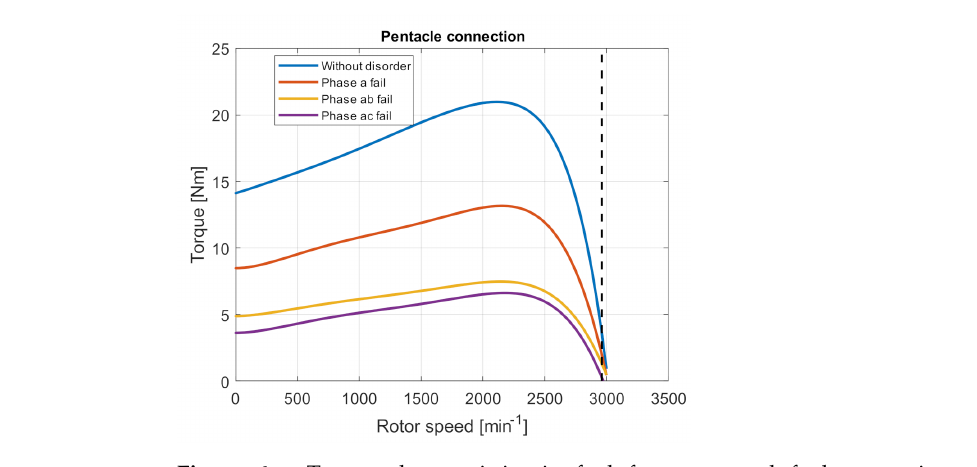
Figure 6. Torque characteristics in fault-free state and fault states in pentacle connection, U IN = 5 × 230 V, 50 Hz.